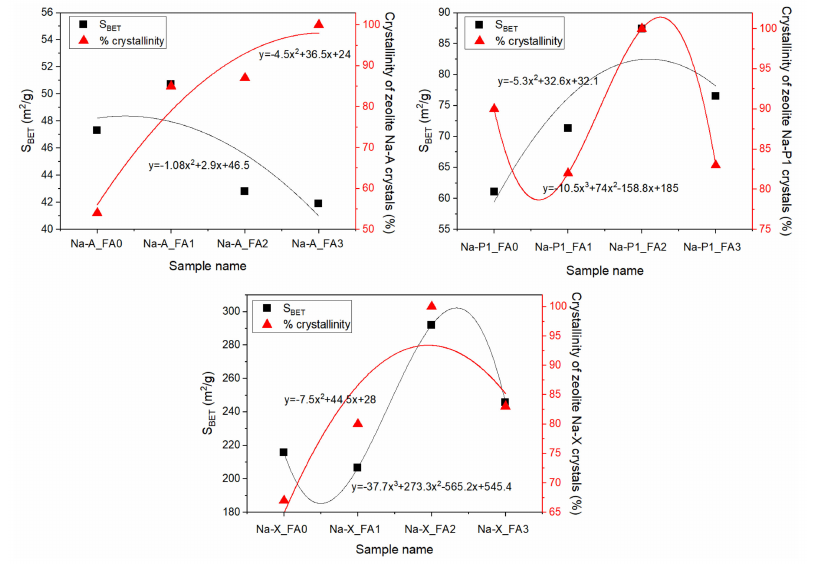
Figure 11. Relationship between specific surface area (S BET ) and (%) crystallinity of the synthesized crystalline product of Na-A, Na-P1, and Na-X